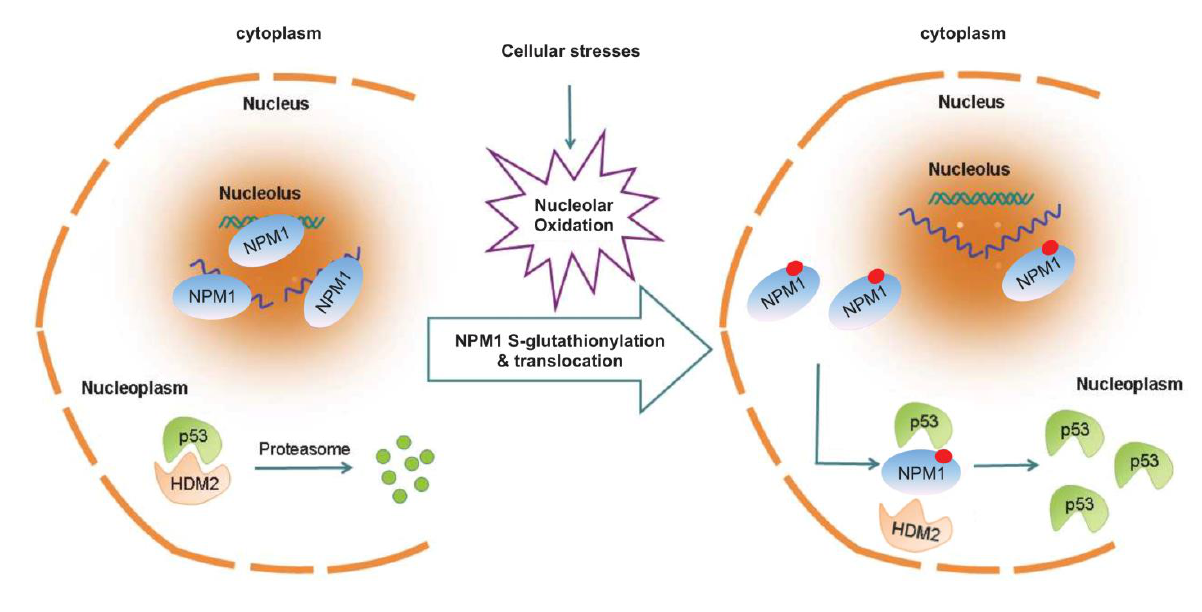
FIGURE 4: NPM1 sensing for nucleolar stress. Nucleolar oxidation is a general response to nucleolar stress. S-glutathionylation and nu- cleoplasmic translocation of NPM1 are indispensable for p53 activation in nucleolar stress